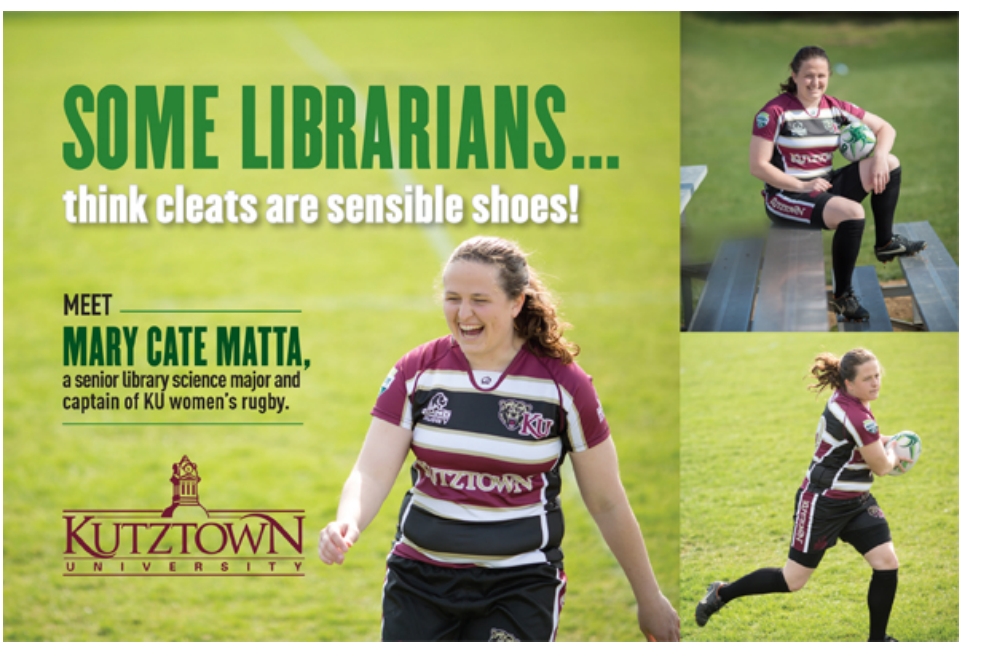
The initial four student profiles featured in the Facebook